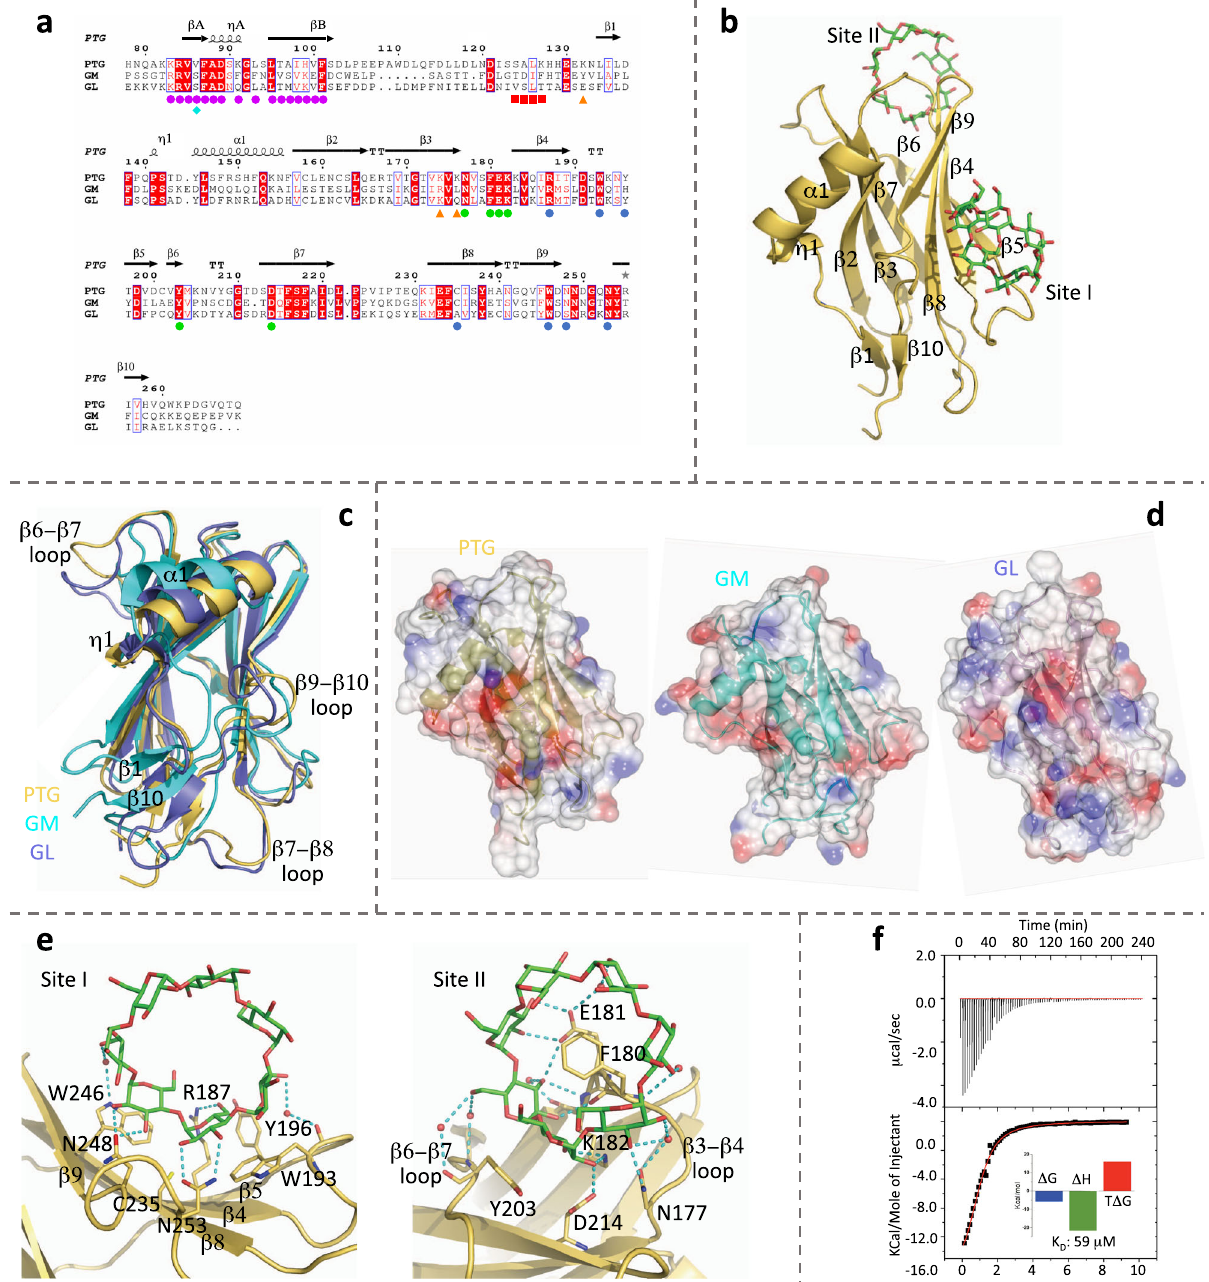
b Crystallographic structure of the PTG CBM21 (yellow) in complex with β - cyclodextrin (green). c Superposition of CBM21 structures of PTG (yellow), GM (cyan),andGL(purple). d ElectrostaticsurfacerepresentationforthethreeCBM21. e Detailed interaction with β -cyclodextrin atthe twobinding sites. f ITCreturns an enthalpically-driven binding of β -cyclodextrin to the CBM21 with a 1:1